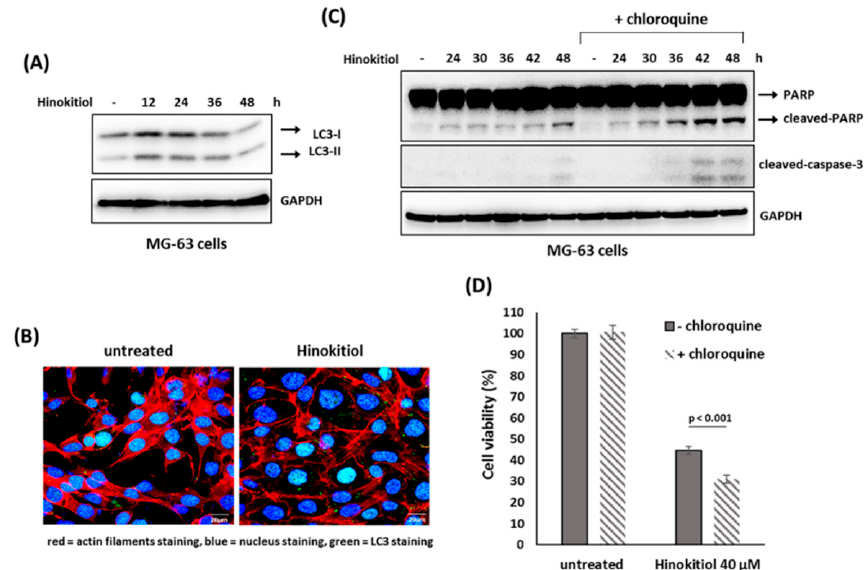
Figure 7. Suppression of autophagy enhances hinokitiol-induced apoptosis in MG-63 cells. ( A ) Hi- nokitiol treatment induces autophagy in MG-63 cells. To detect autophagy formation, MG-63 cells were treated and analyzed as described in Figure 6A. ( B ) Hinokitiol treatment up-regulated au- tophagosome formation in MG-63 cells. To measure LC3 puncta formation, MG-63 cells were treated and analyzed as described in Figure 6B. ( C ) Treatment with chloroquine up-regulates hinokitiol- induced apoptosis in MG-63 cells. The cells were incubated with hinokitiol (40 µ M) with or without chloroquine (CQ) (5 µ M) and collected at the indicated time points. The levels of cleaved caspase 3 and PARP were examined by Western blotting. ( D ) Administration of chloroquine decreases cell viability in hinokitiol-treated MG-63 cells. MG-63 cells were incubated hinokitiol (40 µ M) for 48 h with or without chloroquine (5 µ M). Cell viability of the treated cells was determined by MTT